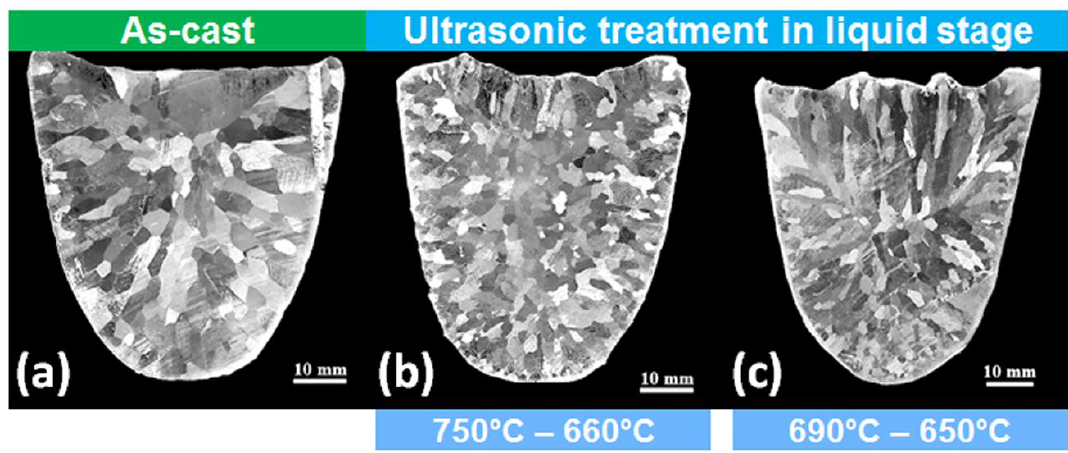
Figure 5. Macrostructure of commercial purity Mg in ( a ) without UST and after UST terminated at ( b ) 660 °C and ( c ) 650 °C [44] .